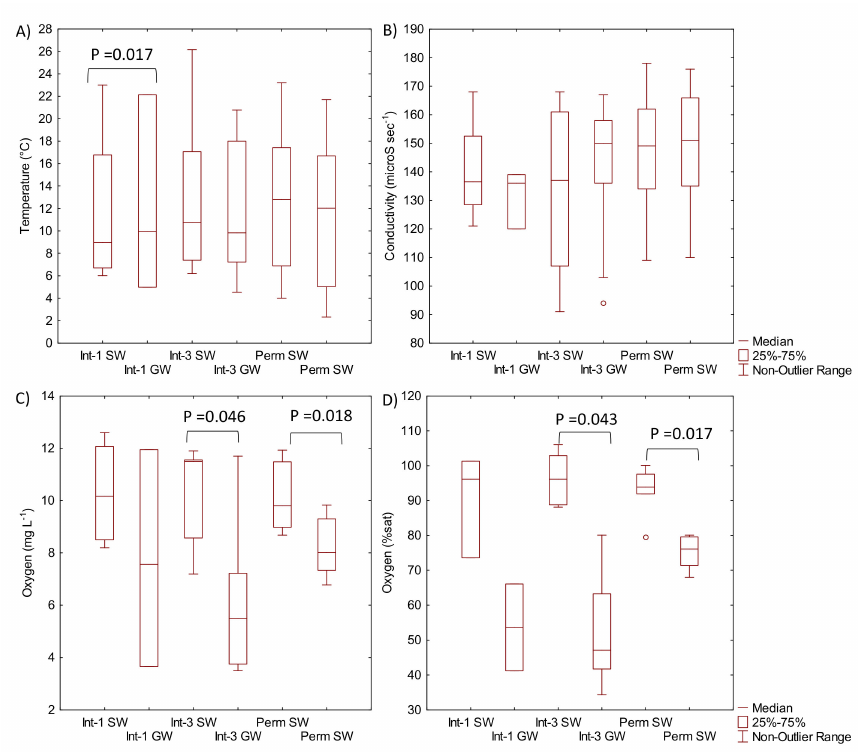
Figure 2. Boxplots of the physico-chemical variables, measured in surface (SW) and hyporheic (GW) water. ( A ) Temperature ( ◦ C). ( B ) Conductivity (microS s − 1 ). ( C ) Oxygen concentration (mg L − 1 ). ( D ) Oxygen (% sat). Significant pairwise comparisons are marked with a bracket, and the corresponding p -values are listed. Perm = permanent piezometer; int-1 = shallow intermittent piezometer; int-3 =